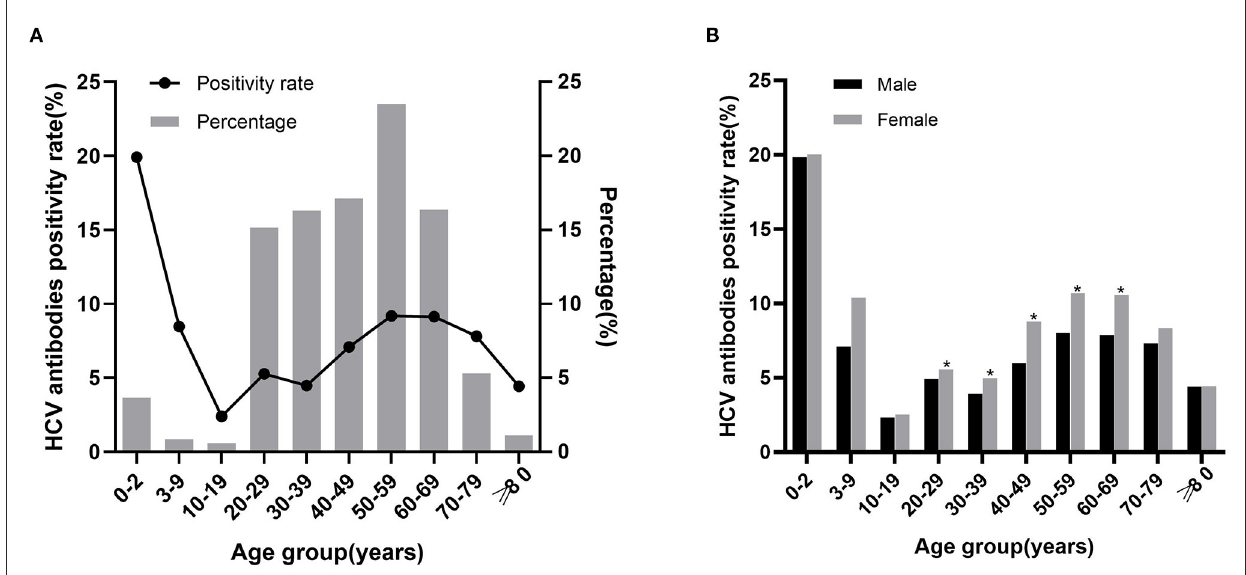
FIGURE1 The relationship between HCV antibody positivity rate with age and sex. (A) HCV antibody positivity rate in different age groups and age distribution of positive patients. The line chart represents the positivity rate, the histogram represents the percentage of positive patients. (B) HCV antibody positivity rate in males and females of different age groups. * P <